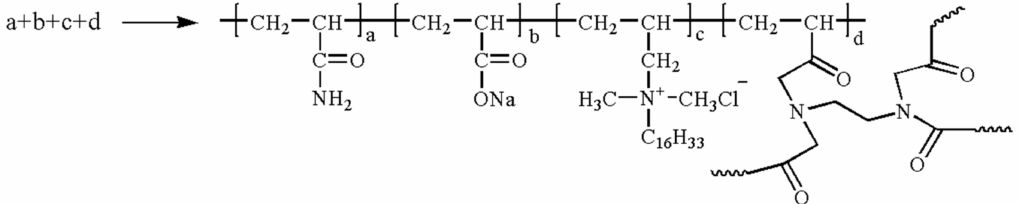
Figure 1. Formula of